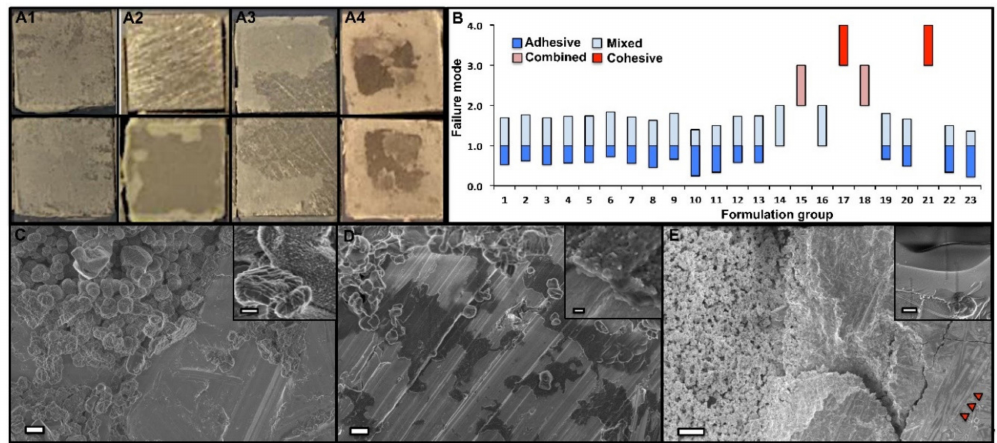
Figure 5. Failure modes observed in PMC. ( A1–A4 ) Representative samples showing cohesive ( A1 , 90% PMC, scored as “4” in the failure mode), adhesive ( A2 , PMMA, scored as “1” in the failure mode), mixed ( A3 , 50% PMC, scored as “2” in the failure mode), and combined ( A4 , 70% PMC, scored as “3” in failure mode) modes of failure. Note the distinct regions of cohesive (edge) and adhesive (central square region) failure in A4. The dimension of all metal cube surfaces was 1 × 1 cm. ( B ) The distribution of the failure mode by group (values of 0–1 adhesive; 1–2 mixed mode; 2–3 combined mode; 3–4 cohesive). ( C–E ) SEM image of the adhesive interface in regions of cohesive ( C , 90% PMC), adhesive ( D , 70% PMC), or combined ( E , 70% PMC + H 3 PO 4 ) mode failure. In ( C ) and ( D ), the metal surface is clearly distinguished by the polished roughness pattern. In ( E ), the interface between cohesive failure (left side) and adhesive failure (right side of image) is shown. The inset images in C show a higher magnification image of the calcium phosphate particle surface; in D show a high magnification image of the organic surface layer fragments that remain bound to the opposing cube surface, and in E show a cross section of a fractured disc of 70% PMC. The inset image in E was from a separate set of 70% PMC that was cured (ambient conditions) as a disc, on a polyethylene surface, to allow for undisturbed formation and imaging of the organic layer. The inset scale bars represent 1 µ m, 200 nm, and 2 µ m for C, D, and E,